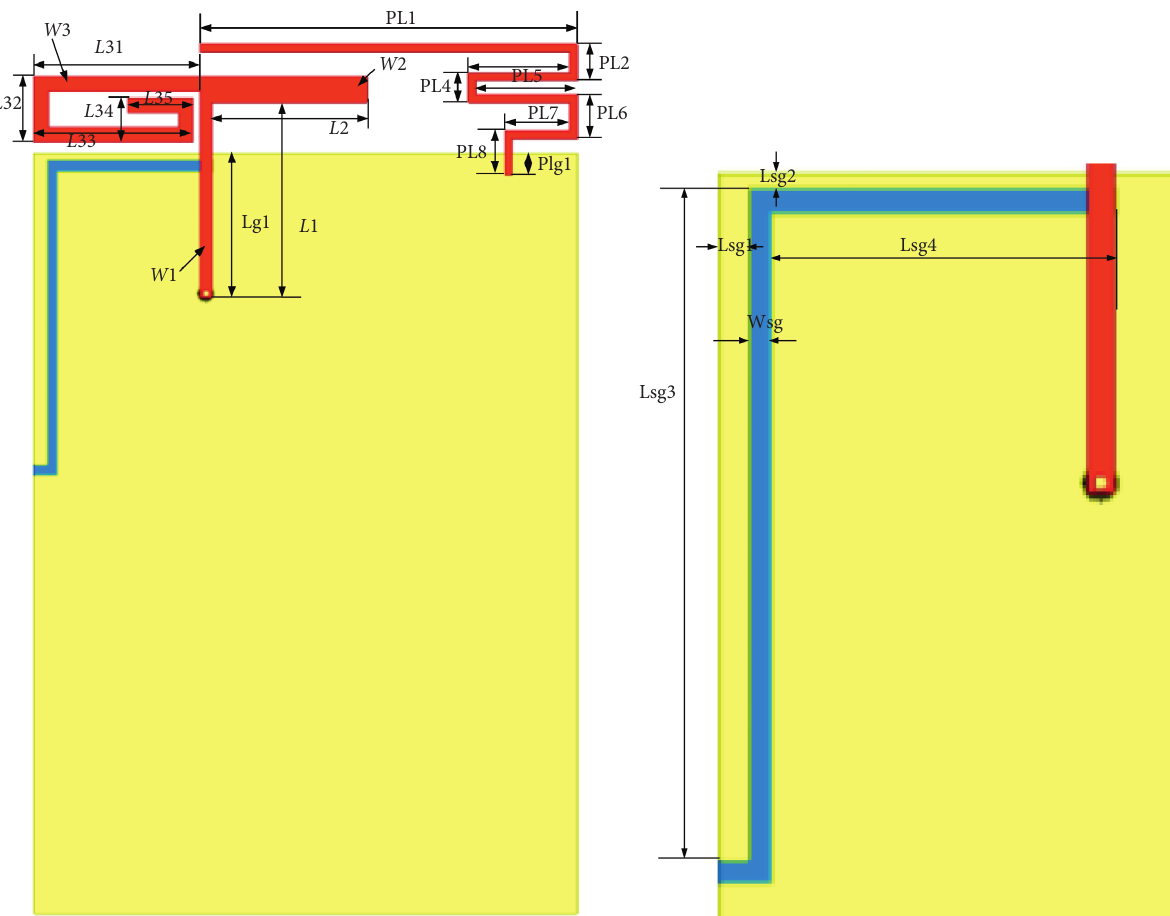
Figure 4: Schematic diagram of the multiband microstrip